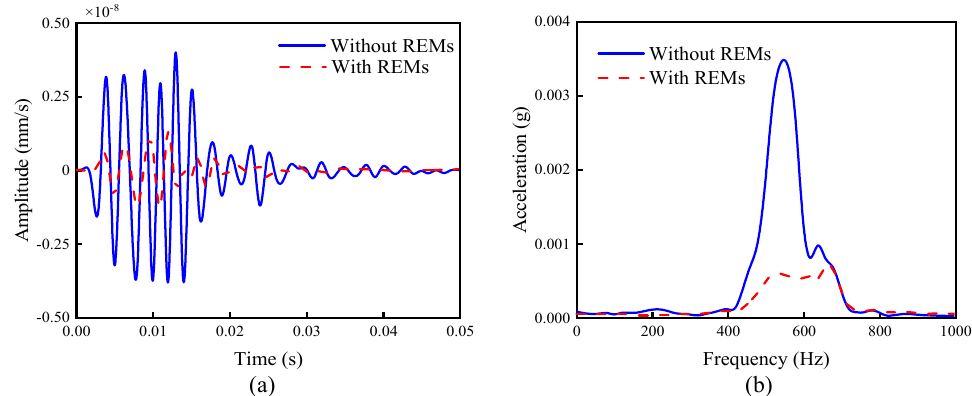
Figure 14. 580 Hz, 21-cycle excitation signal response. ( a ) Time–history curve of response signal; ( b ) Fourier spectrum of response signal.